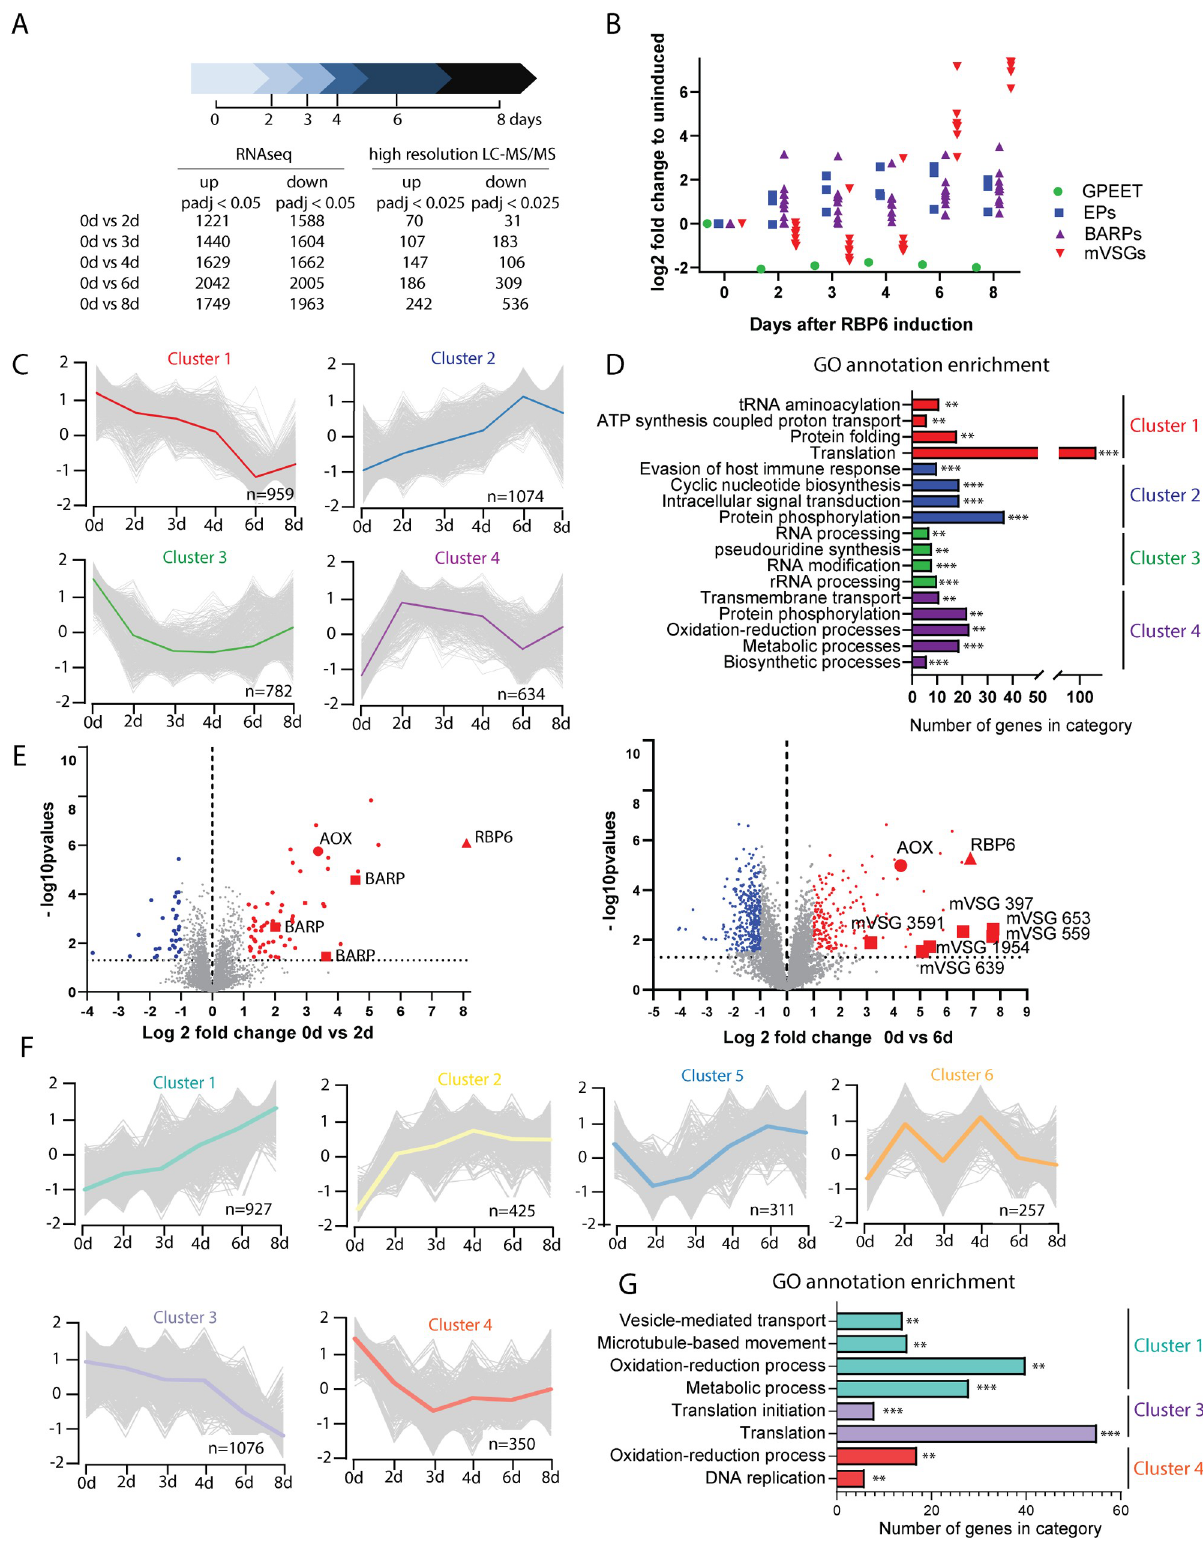
Fig 2. RBP6 OE differentiation transcriptome and proteome. (A) Scheme of the differentiation process and the experimental time points. The RBP6-induced cells were harvested and analyzed by RNA-Seq and label-free quantitative mass spectrometry at different time points, as indicated.